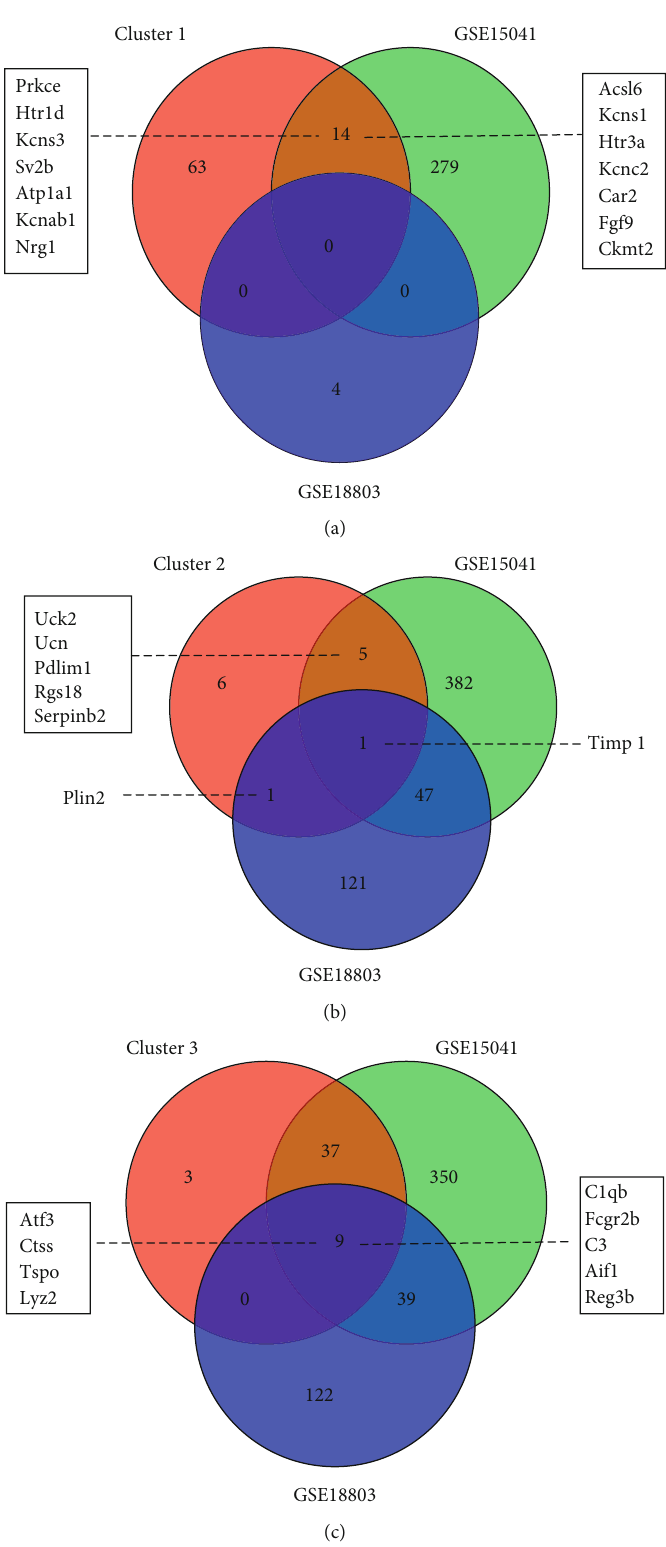
Figure 6: The intersection of cluster genes with di ff erentially expressed genes obtained from GSE15041 and GSE18803 databases. (a) The intersection of cluster 1 genes and downregulated genes obtained from GSE15041 and GSE18803 databases. (b) The intersection of cluster 2 genes and upregulated genes obtained from GSE15041 and GSE18803 databases. (c) The intersection of cluster 3 genes and upregulated genes obtained from GSE15041 and GSE18803